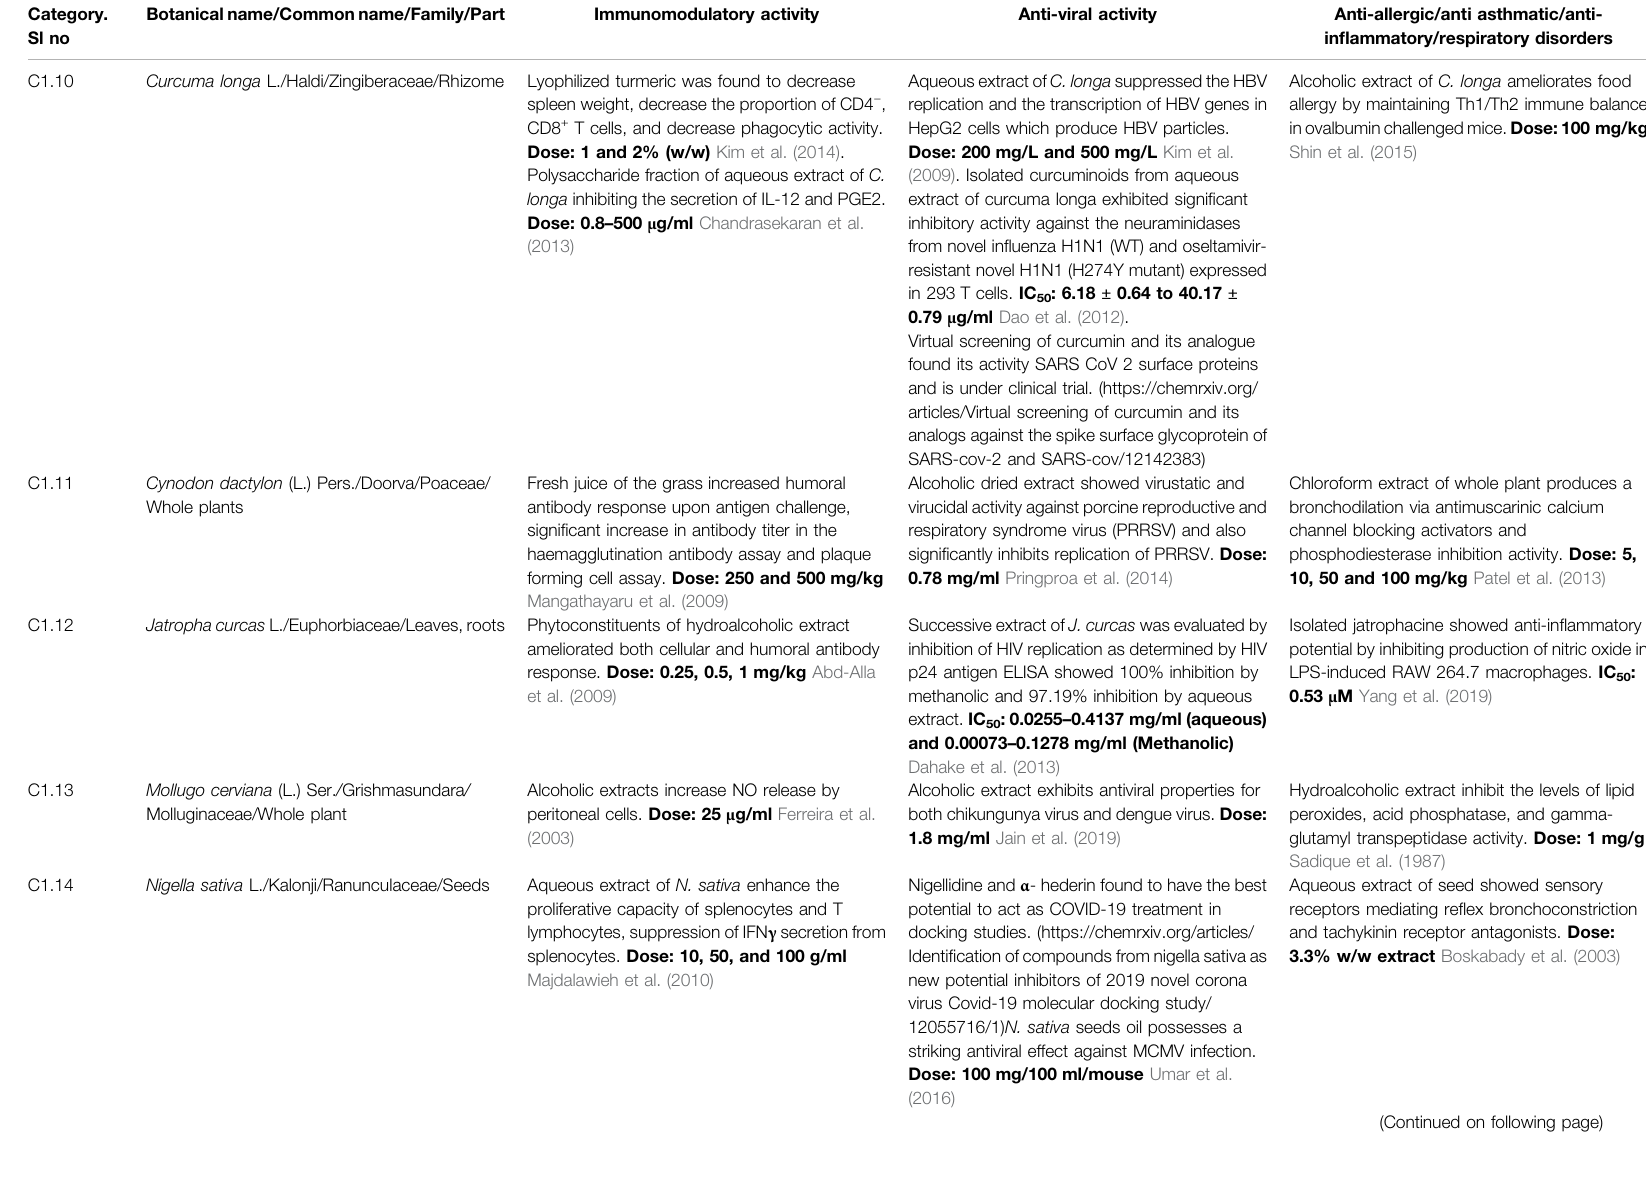
TABLE 5 | ( Continued ) List of Indian Medicinal Plants/AYUSH drugs with proven immunomodulatory, antiviral and anti-allergic/anti-in fl ammatory/anti-asthmatic activity having potential for exploring against COVID 19 categorized for prioritization on the basis of their earlier